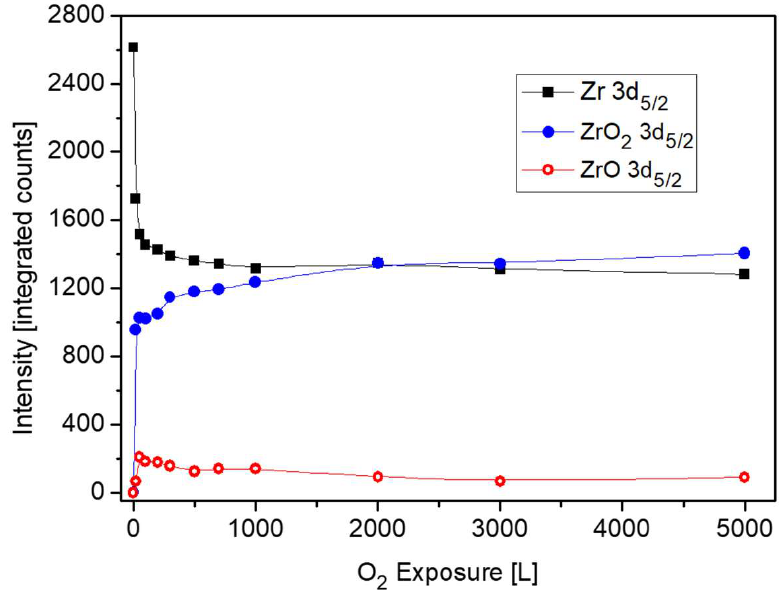
Figure 7. The metallic and oxides intensities of Zr vs. oxygen exposure at room temperature. Analysis of the Sn and Ni spectra revealed that only very light oxidation of Sn can be seen at high exposures, with no oxidation signs of the Ni, similarly to the TiNiSn case (spectra not shown, see for similar results [11]). The attenuation of the Sn and Ni intensity during oxygen exposure are depicted in Figure 8.